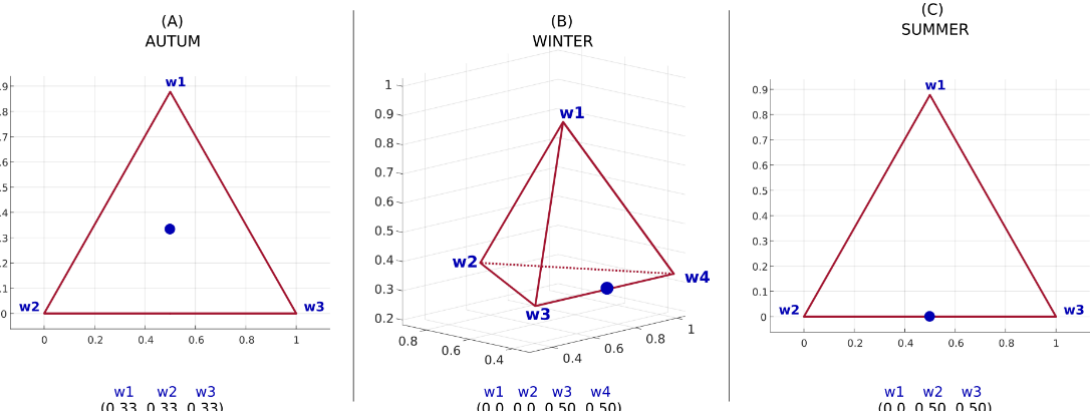
Figure 14. Adjusted weight combination that configures the smallest forecast errors for the seventeen generation plants, separated by season: ( A ) Autumn—(0.33, 0.33, 0.33); ( B ) Winter—(0.0, 0.0, 0.5, 0.5); ( C ) Summer—(0.0, 0.5, 0.5) and spring, which is not plotted because the combination elements contained 5 factors (hard to see): (0.0, 0.0, 0.33, 0.33, 0.33). Source: own authors.